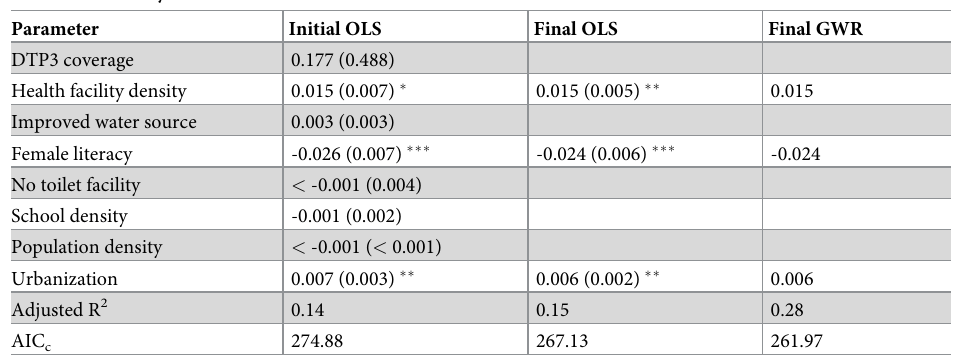
a For the OLS models, estimates correspond to the coefficients and the standard error in parentheses. b For the GWR model, estimates correspond to the mean coefficients.